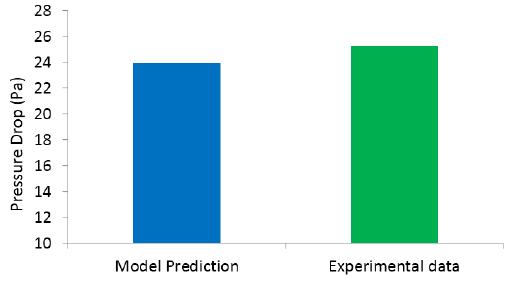
Figure 10. Solid volume fraction contour of Case 3 between 20 and 40 s.